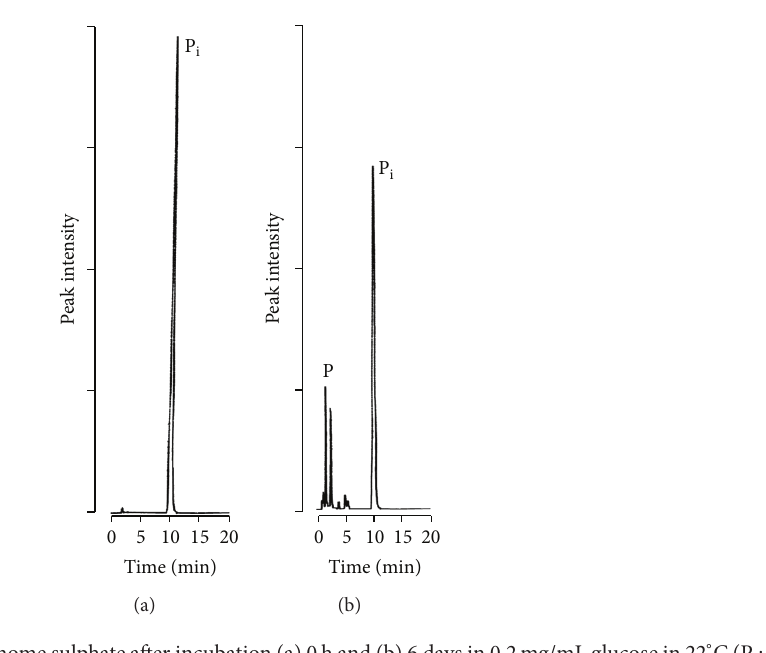
Figure 2: HPLC chromatogram of cefquinome sulphate after incubation (a) 0 h and (b) 6 days in 0.2 mg/mL glucose in 22 ∘ C (P i : cefquinome sulphate, P: degradation